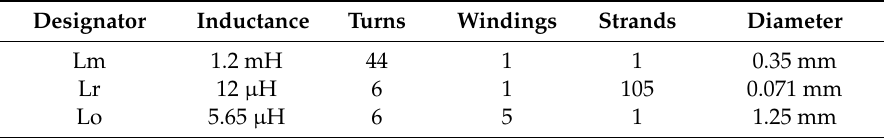
Table 6. Inductance values and their winding realization in reference